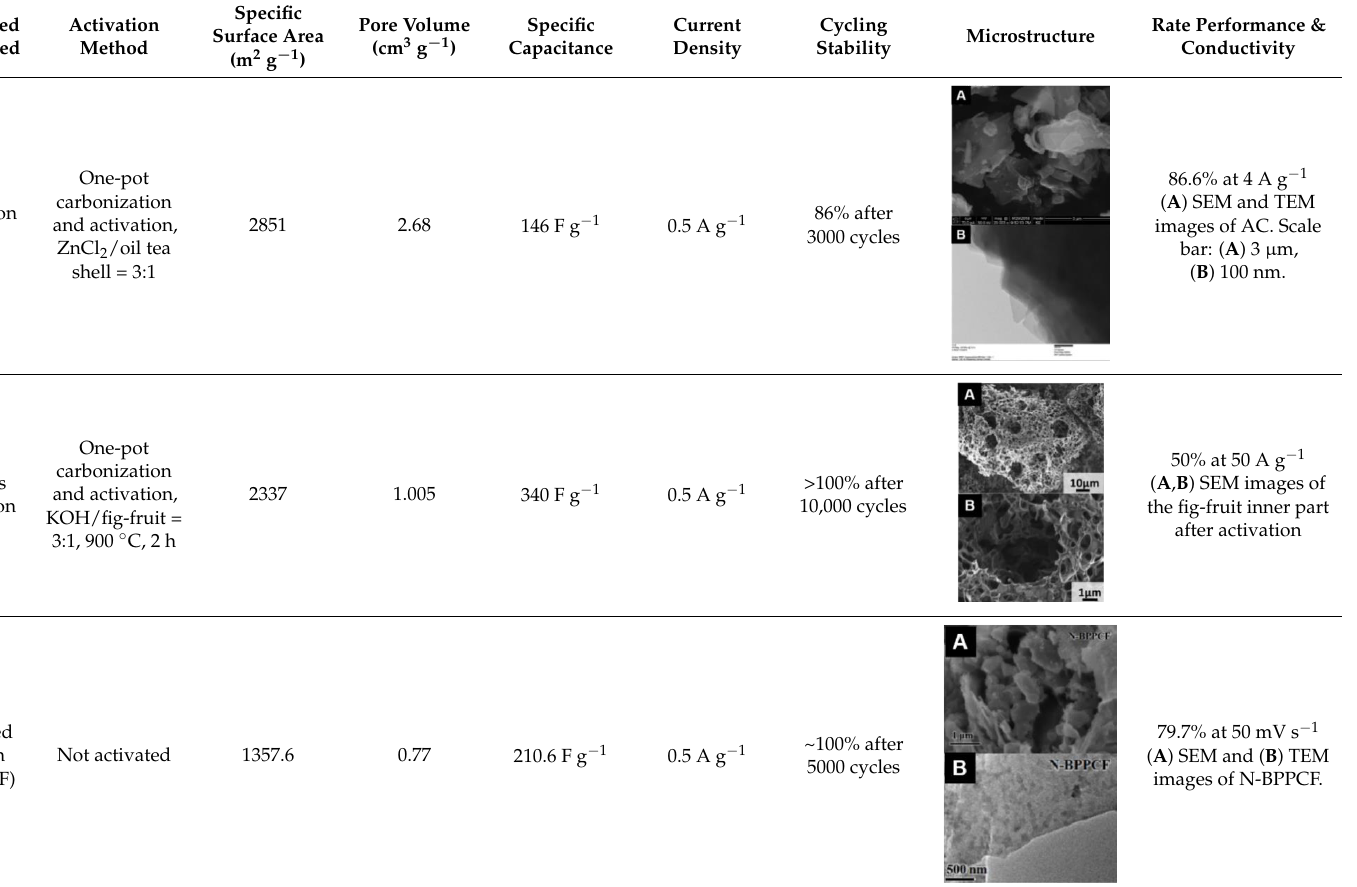
Fig-fruit: Fig-fruit: inner part inner